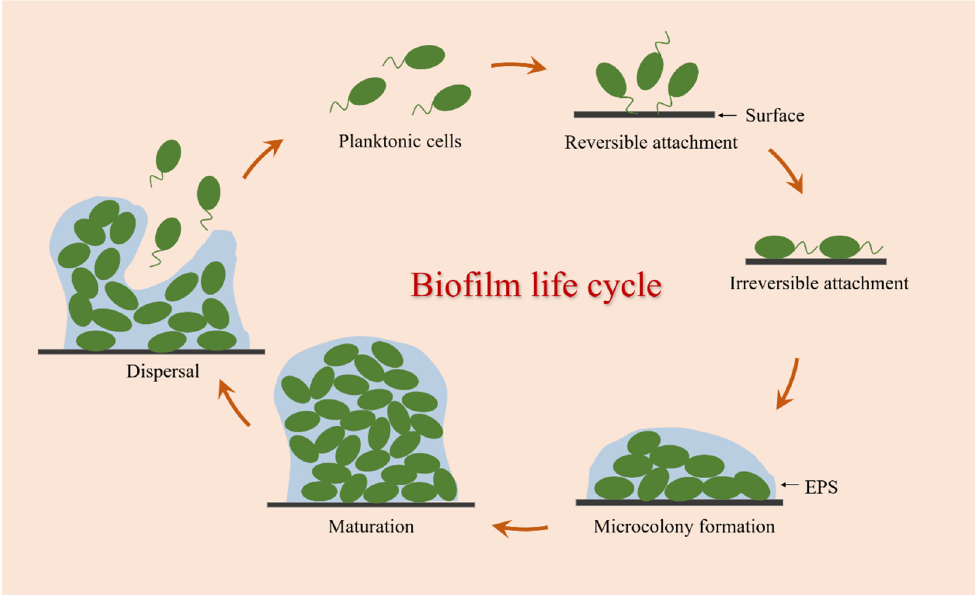
Figure 1. Biofilm formation process.